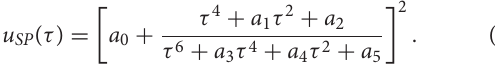
FIGURE 2 | Evolution of the LLE obtained by integration of Equation (3) with α instantaneous profile of the highest peak obtained in the red, cyan, and magenta box and the red line correspond to the best fit using the maximally compressed second order Peregrine soliton (8),